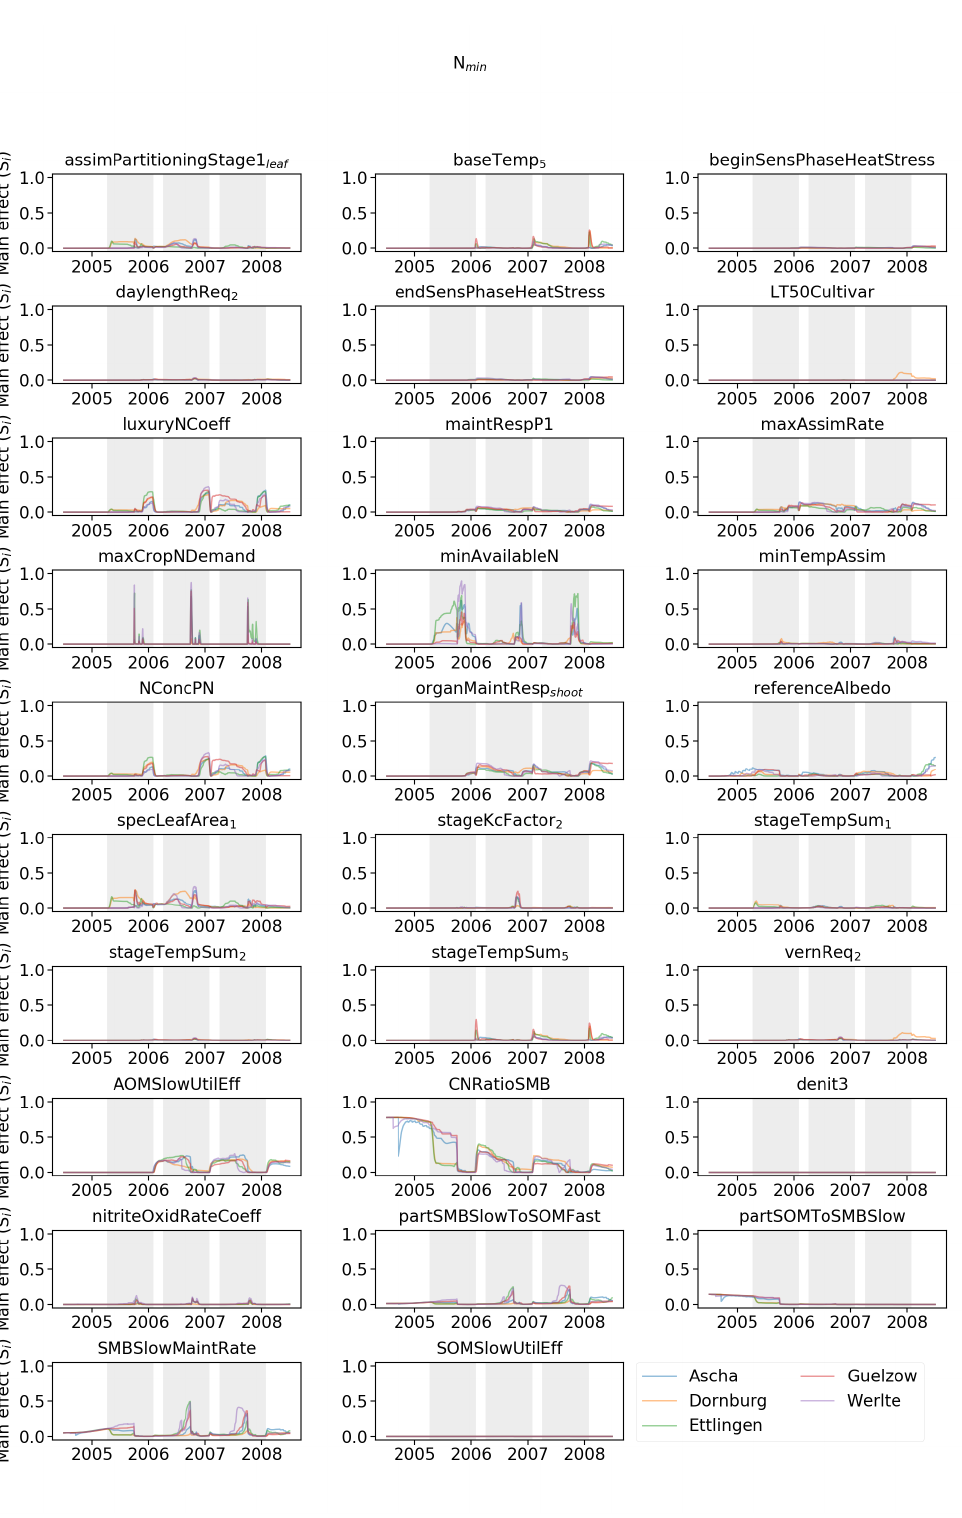
Figure A6. Daily S i values calculated using the extended FAST method for N min differentiated among the different